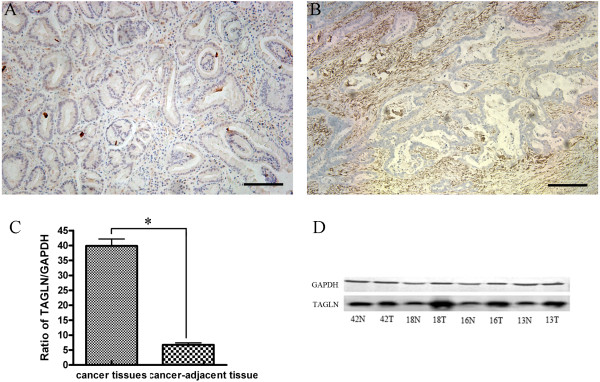
Expression of TAGLN in human gastric cancer tissues. A: TAGLN expression level in normal gastric tissue by IHC. Scale bars, 100 μm. B: TAGLN is overexpressed in the stroma of human gastric cancer by IHC. Scale bars, 100 μm. C: TAGLN mRNA is upregulated in human gastric cancer analyzed by QRT-PCR. D: TAGLN protein is upregulated in human gastric cancer analyzed by Western blot. Values represent the mean ± SD from at least three separate experiments, each conducted in triplicate. *, P < 0.001 by paried-samples T test.